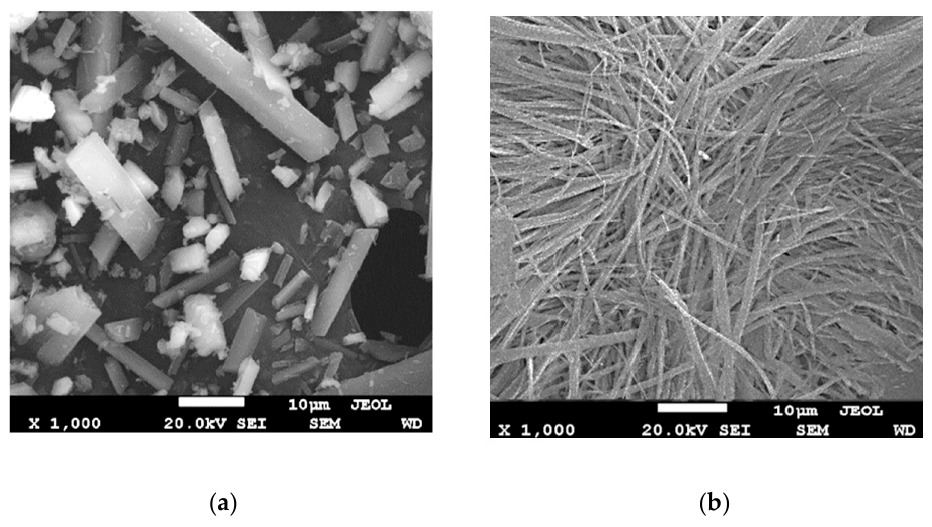
Figure 3. Morphology of taxifolin particles of the studied solutions ( × 1000): ( a ) control; ( b ) mi- crostructured (ultrasound 600, 7